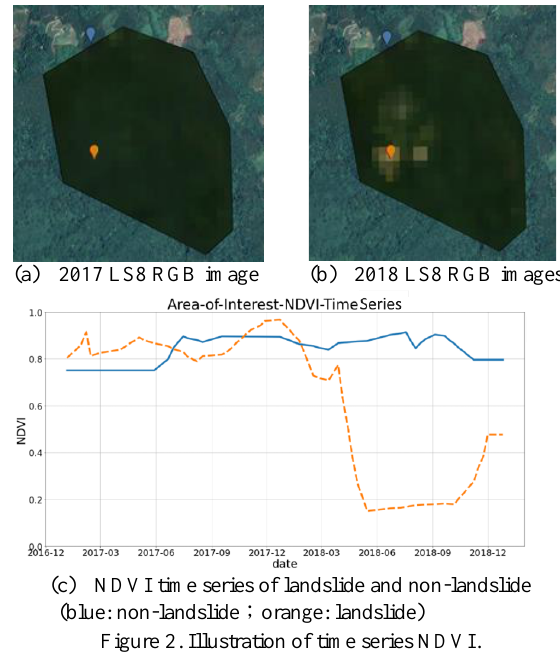
Figure 2. Illustration of time series